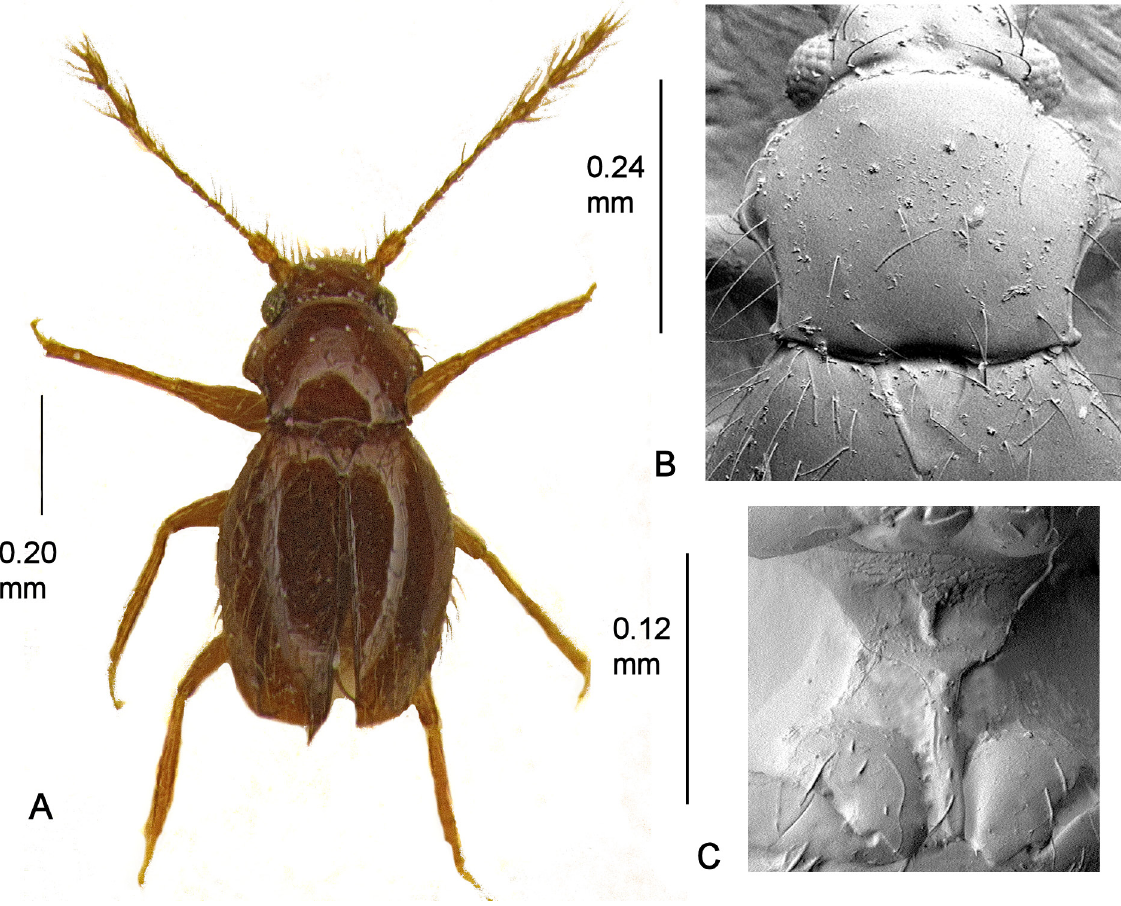
Fig. 88. Cissidium basale Motschulsky, 1855. A . Habitus. B . Pronotum, × 385. C . Mesoventrite showing median process of collar, mid-keel and keel, ×